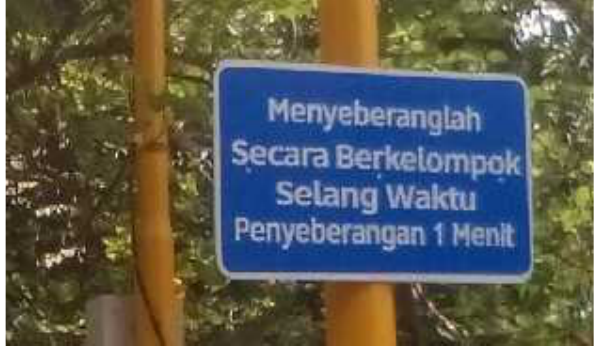
Figure 5. A Public Sign in Indonesian